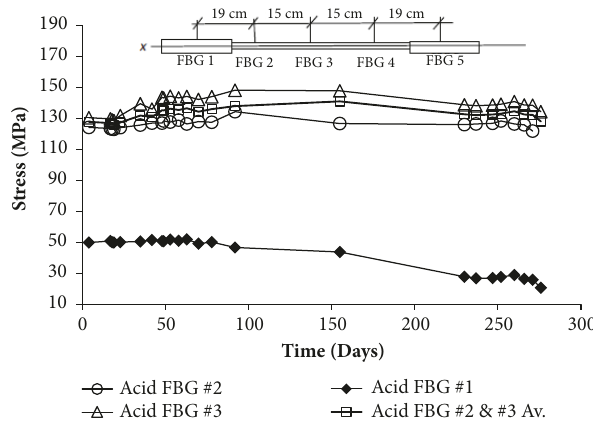
Figure 7: Stress versus time FBG sensors (acid).